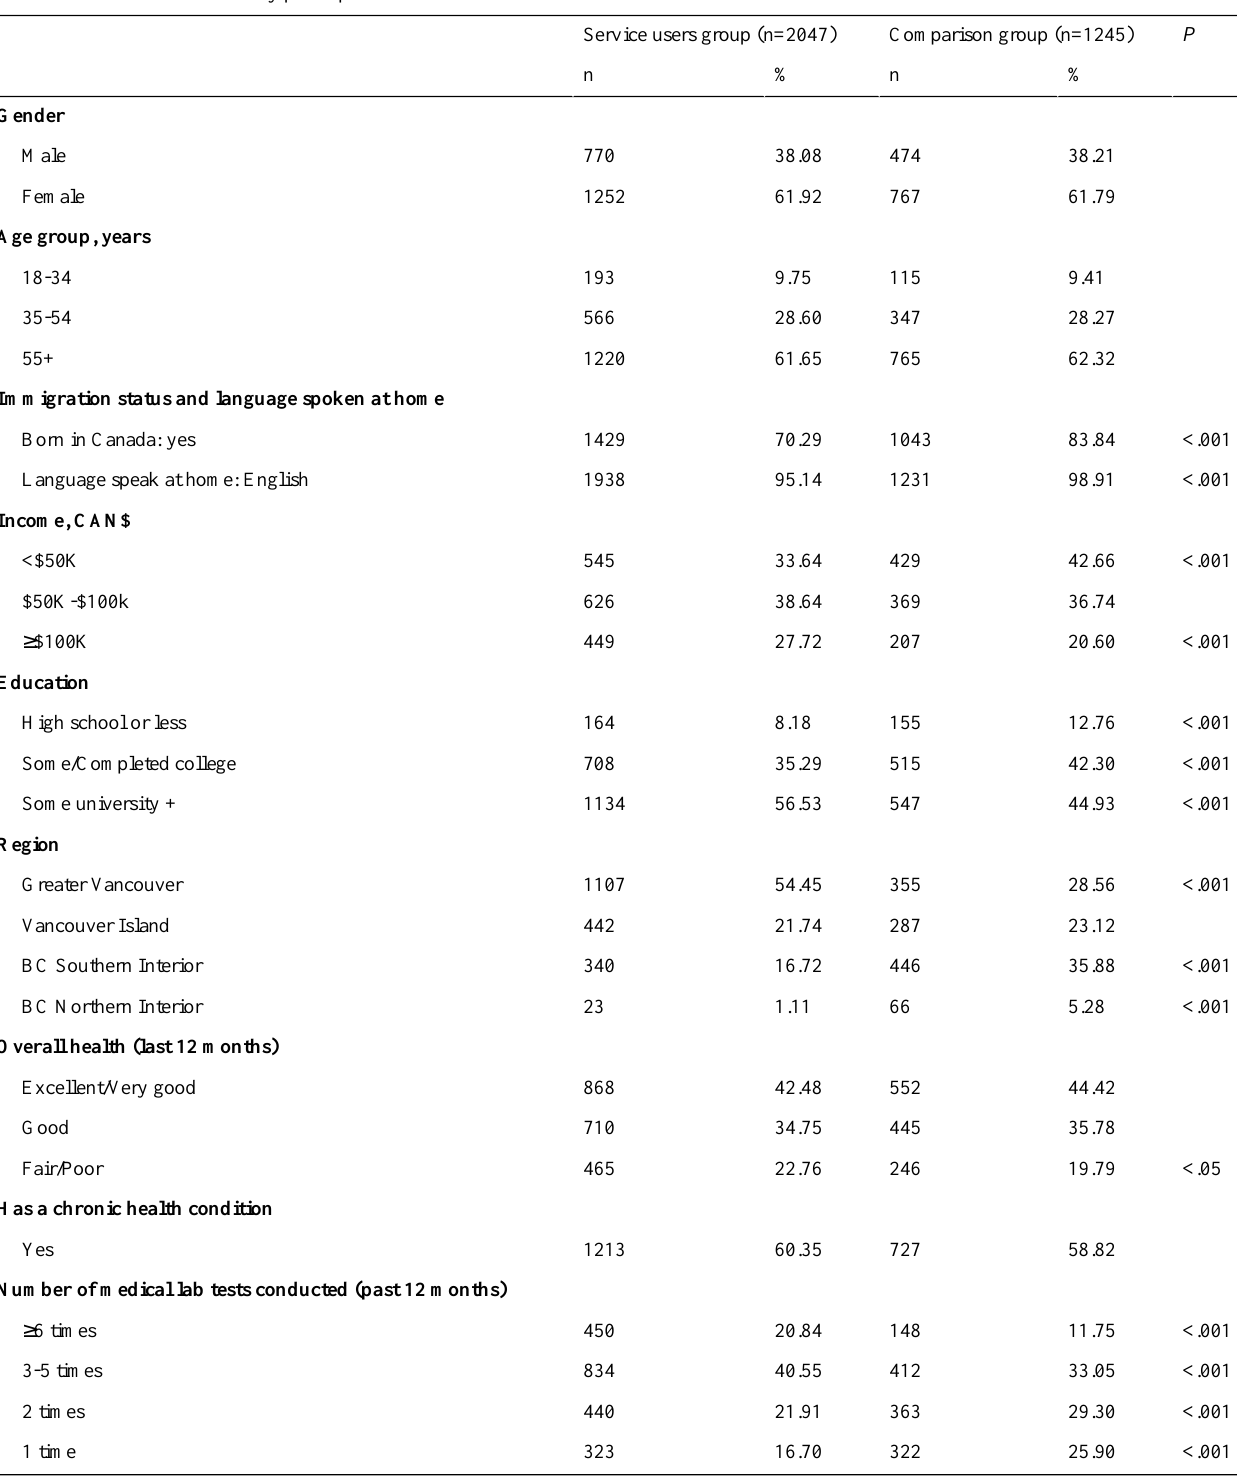
Table 1. Characteristics of survey